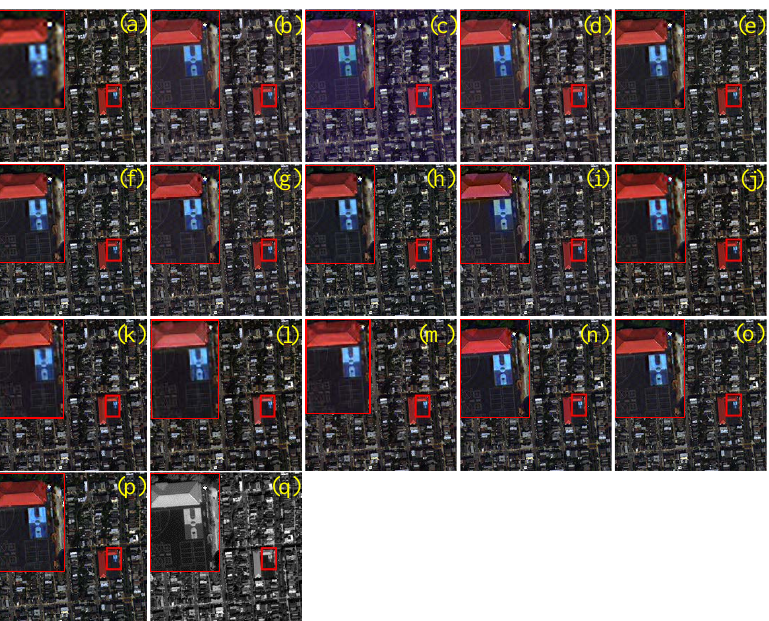
Figure 7. Visualization of image sharpening results in full resolution. The input LRMS and PAN images from the WorldView-2 dataset with sizes of 256 × 256 and 1024 × 1024, respectively. The en- larged red box view is located in the upper left corner. ( a ) EXP; ( b ) PCA; ( c ) IHS; ( d ) GS; ( e ) HPF; ( f ) SFIM; ( g ) Indusion; ( h ) FE-HPM; ( i ) PWMBF; ( j ) PNN; ( k ) DRPNN; ( l ) PercepPan; ( m ) PGMAN; ( n ) BAM; ( o ) MC-JAFN; ( p ) Our; ( q )